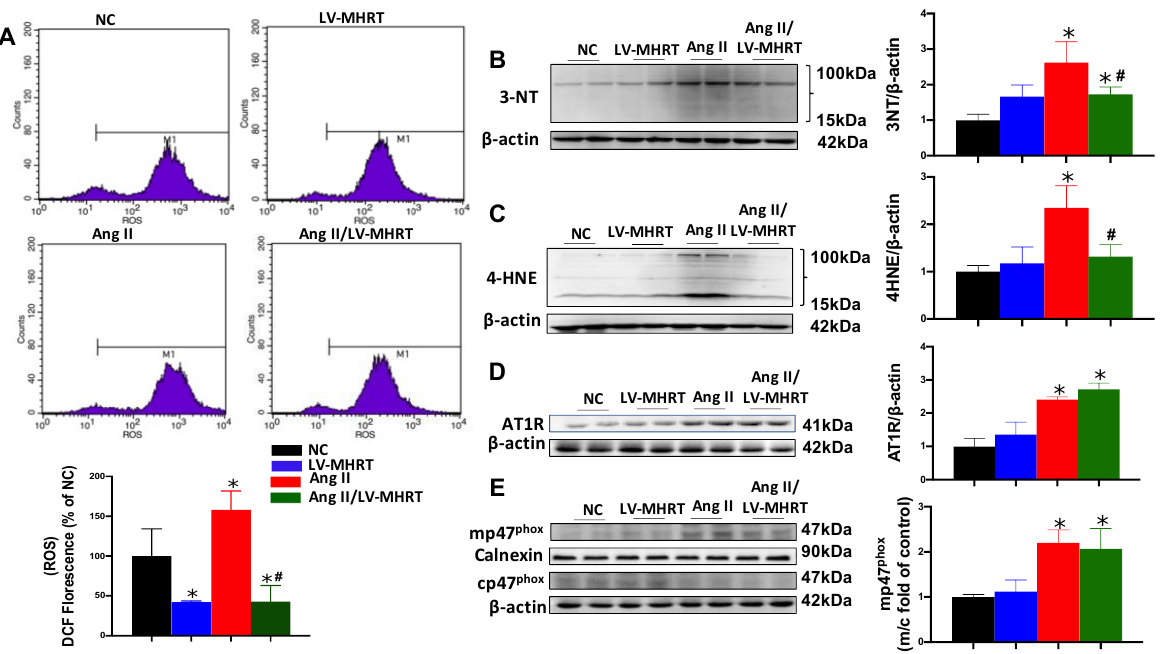
of AT1R and p47 phox . AT1R expression was significantly upregulated in the Ang II group at the protein levels and was not affected by MHRT overexpression (Figure 5D). Cytoplasmic subunit cp47 phox is phosphorylated and translocated to the cell membrane (mp47 phox ) to form an active NOX complex. Ang II treatment significantly upregulated the expression ratio of mp47 phox to cp47 phox in AC16. However, there was no difference of the ratio between the Ang II and Ang II/LV-MHRT groups (Figure 5E). These findings suggested that MHRT plays its antioxidative role independent of Ang II-induced ROS production.